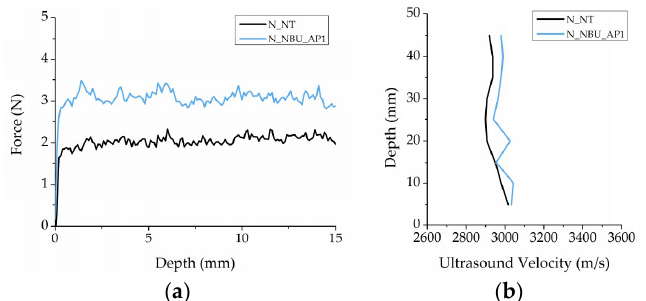
Figure 10. Noto stone treated with NBU applied by brushing till saturation AP1 (N_NBU_AP1): ( a ) drilling resistance and ( b ) UPV profile. NT: Untreated stone.